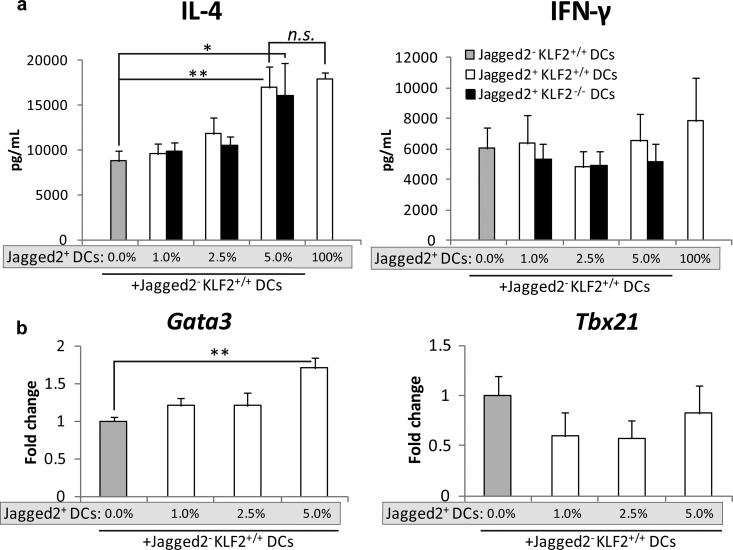
Jagged2-expressing DCs promote Th2 responses. (a) IL-4 and IFN-γ production by restimulated T cells after coculture with increasing percentages of Jagged2+ cells from KLF2+/+ or KLF2−/− BMDCs loaded with HK H. capsulatum (4 experiments). (b) Th1/Th2 master regulator expression in cocultured T cells (3 experiments). *, P < 0.05, and **, P < 0.05, for comparison with the results for the control by one-way ANOVA. Data represent the mean results ± SEM.